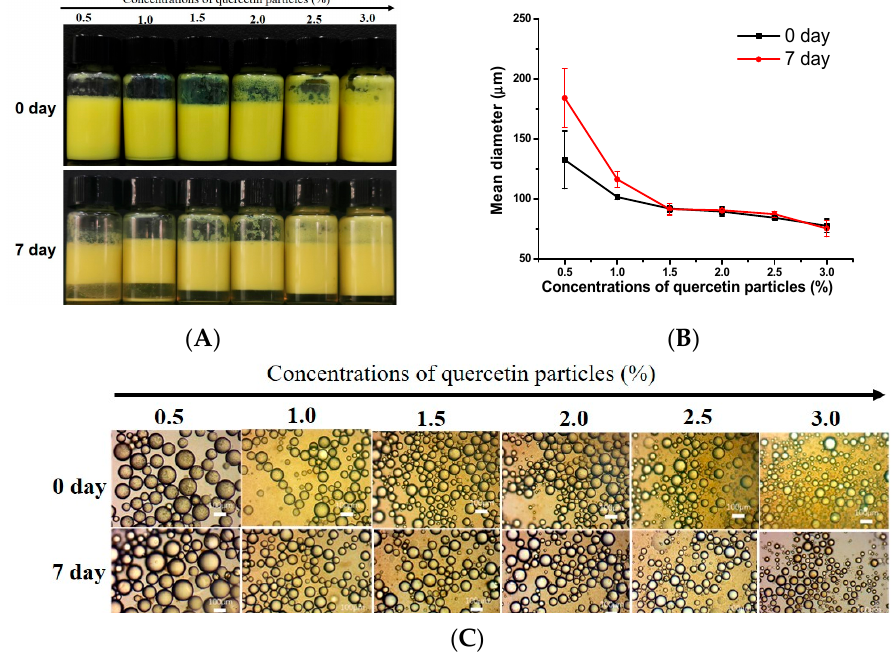
Figure 6. The effect of particle concentrations on visual appearances ( A ), mean diameter ( B ) and optical microscopy images ( C ) of emulsions prepared by antisolvent quercetin particles (the antisolvent ratio of quercetin particles was 1:1, c = 0–3%) after storage for day 0 and day 7. The ratio of oil/water of the emulsion is 1:1. The scale bar is 100 µm.